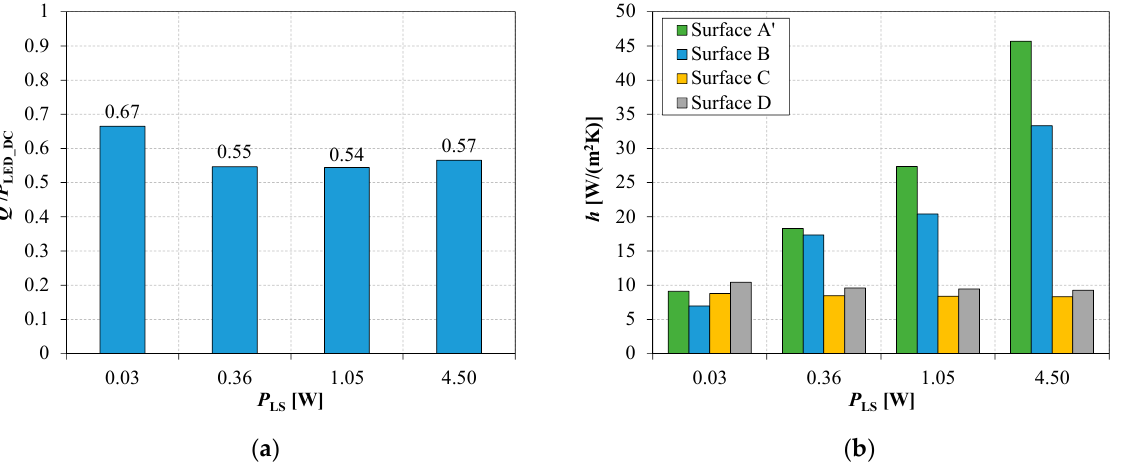
Figure 12. ( a ) The ratio of the heat flow rate of the LED lamp to the electric power delivered to the diodes. ( b ) The heat transfer coefficient at different surfaces of the LED lamp for various values of the input power driving SJA. Surface A’ corresponds to the total heat transfer area of the heat sink. In Figure 12b, the heat transfer coefficient at different surfaces of the LED lamp for various values of the power at the input of the synthetic jet actuator is presented. It is important to note that the heat transfer coefficient determined according to the methods described in Section 2 represents the effects of both radiation and convection. For the lowest power at the SJA input of P LS = 0.031 W, the values of the heat transfer coefficient at all investigated surfaces A’, B, C, and D were lower than 11 W/(m 2 ·°C). The heat transfer coefficient at surface B was the lowest and equal to h B = 7 W/(m 2 ·°C), while at surfaces C and D, it reached h C =8.8 W/(m 2 ·°C) and h D = 10.4 W/(m 2 ·°C), respectively. Surface D (PMMA plate) had higher emissivity than the aluminum plate (surfaces C and D), thus the radiant heat flux at surface D was higher. With the increase in the input power to the value of P LS = 4.50 W, the heat transfer coefficient at surfaces A and B increased to h A = 45.7 W/(m 2 · ◦ C) and h B = 33.3 W/(m 2 · ◦ C), respectively, while at surfaces C and D, it decreased slightly to the values of h C = 8.3 W/(m 2 · ◦ C) and h D = 9.3 W/(m 2 · ◦ C),